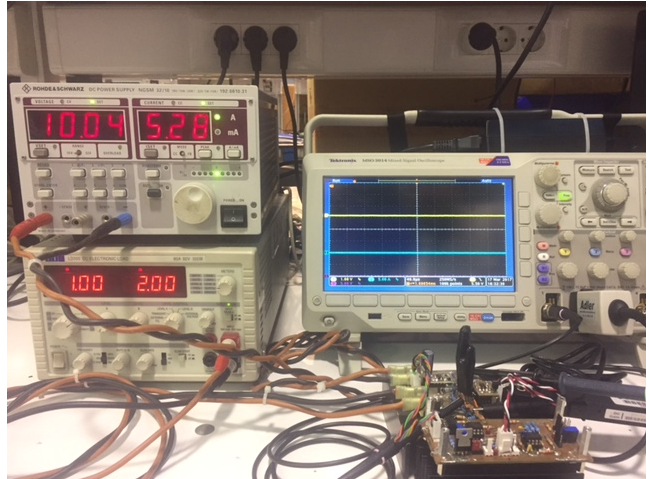
Figure 11. The experimental setup used to validate the theoretical and the simulation results corresponding to the buck converter under two-loop hysteretic